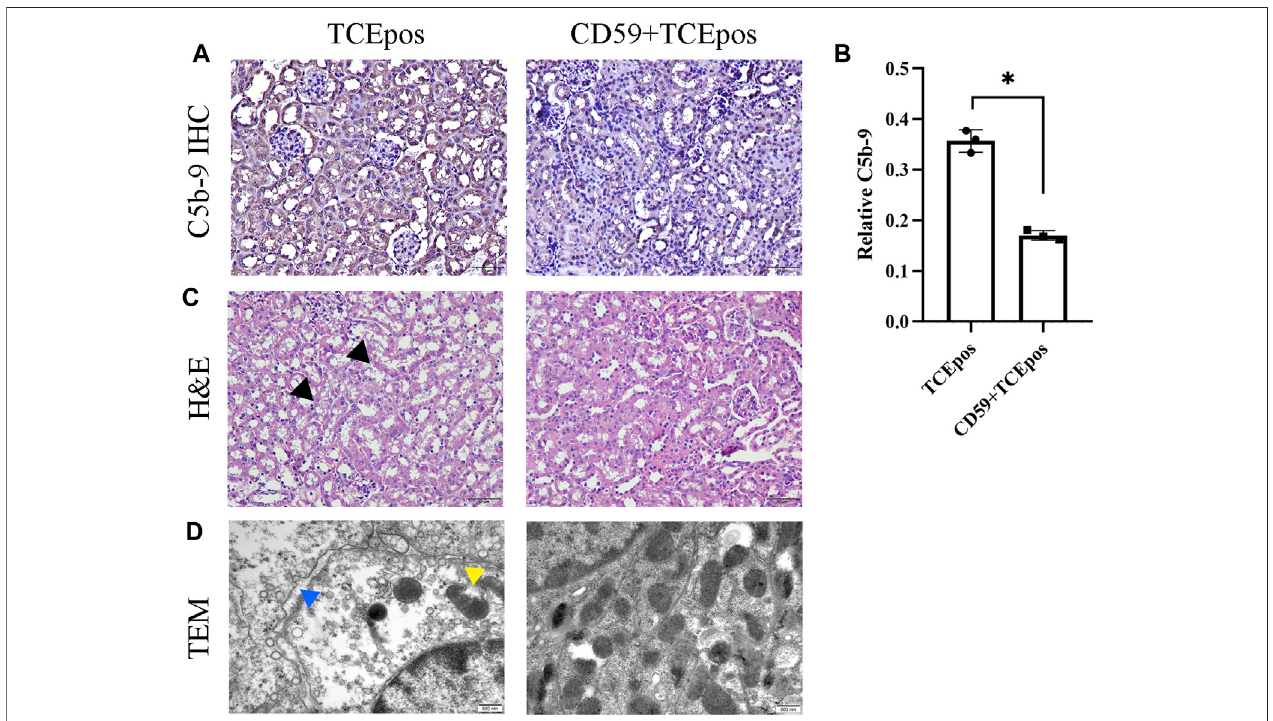
FIGURE 7 | C5b-9 aggravated RTEC damage in TCE-sensitized mice. (A) Expression of C5b-9 in kidney tissue was analyzed by IHC. Twenty- fi ve μ g/mouse sCD59-cyspretreatment iseffective againsttheassemblyofC5b-9.Magni fi cation, ×400.Allthescalebars represent 50 μ m. (B) Relativeexpression ofC5b-9assessed by the average optical density value in Image J. (C) H&E staining of the kidney (magni fi cation, ×400). The black arrow shows tubular swelling, vacuolar degeneration, or detachment of renal tubular epithelial cells. The scale bars represent 50 μ m. (D) Transmission electron microscopy of RTECs (magni fi cation, ×30000). The yellow arrow shows mitochondrial edema and vacuolar degeneration, abnormal internal ridge structure, and ruptured mitochondrial membrane. The blue arrow shows an increased distance between cells. The scale bars represent 500 nm sCD59-cys pretreatment could ameliorate both the pathological changes of renal tubules and ultrastructural damage ofRTECs. Dataarerepresentative ofthree independent experiments and are expressed asthe mean ±SD. n = 3 – 5/group.Levels ofsigni fi cance were de fi ned as below: * p < 0.05.